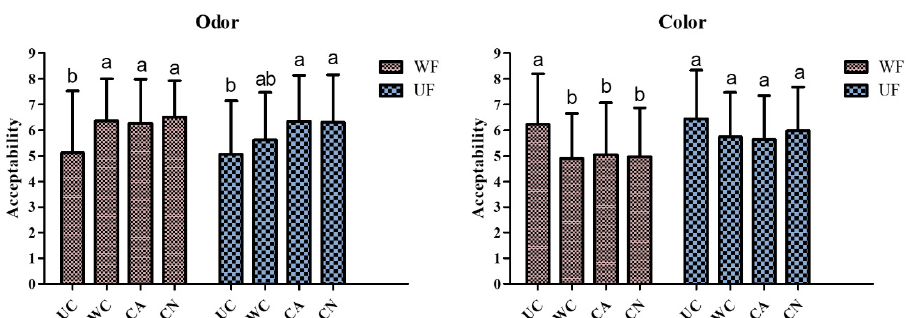
Figure A2. Odor and color acceptability (50 untrained judges) of fresh beef samples stored for 21 d evaluated on treatments using coated samples [API:CH, 4:1 ( w / w )] (WF) or sample coating removal before analysis (UF). UC: control sample without coating; WC: coated sample without any addition; CA: coated sample added with emulsified oregano essential oil (OEO); CN: coated sample added with mesoporous silica nanoparticles loaded with oregano essential oil (MSNO). In the same group (WF or UF) columns not connected by the same letter are significantly different ( p < 0.05).